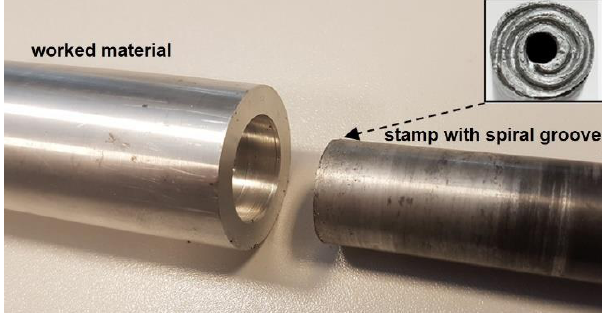
Figure 2. Image of the stand with the processed material removed (inset presents the grooves cut at the stamp face).